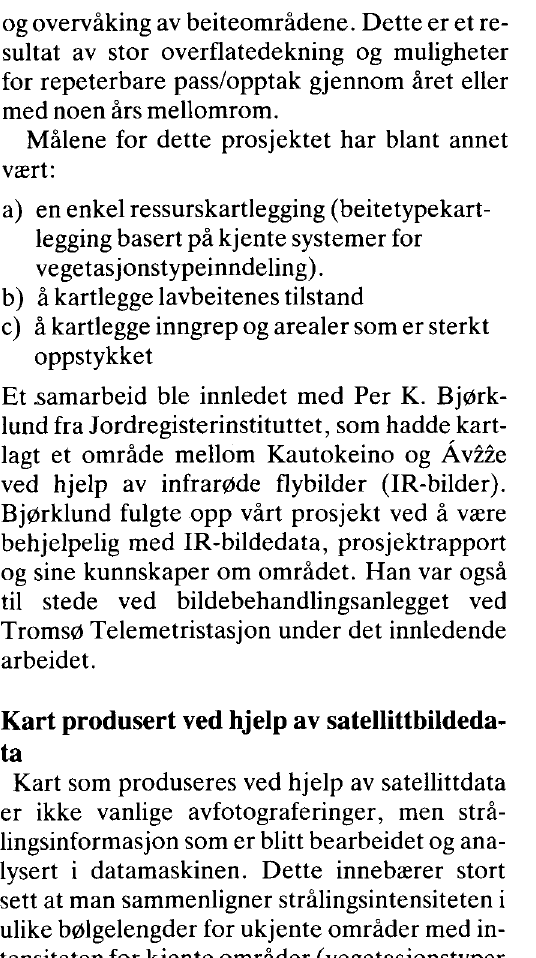
Table 1 . Applied image